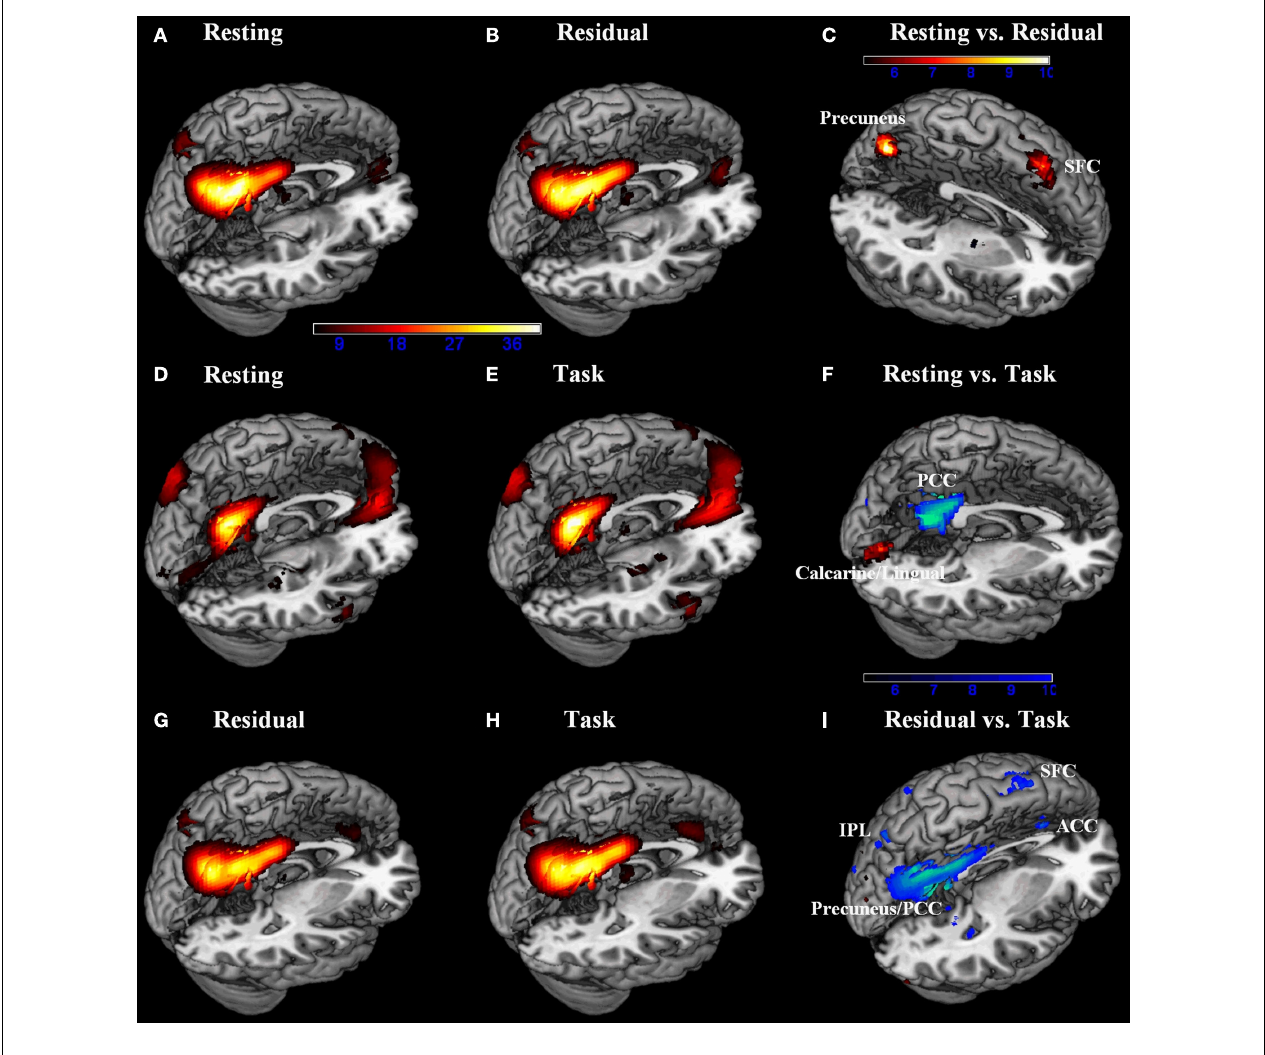
activity during resting compared to task residuals; (F) the posterior cingulate cortex (PCC) showed less activity, while the calcarine/lingual showed greater activity during resting compared to task. (I) the PCC/precuneus, anterior cingulate cortex (ACC), bilateral inferior parietal lobule (IPL), and bilateral SFC showed less activity during task-residual compared to task. Color bars represent voxel t values. Hot: resting > residual, resting > task, or residual > task; Cool: residual > resting, task > resting, or task >